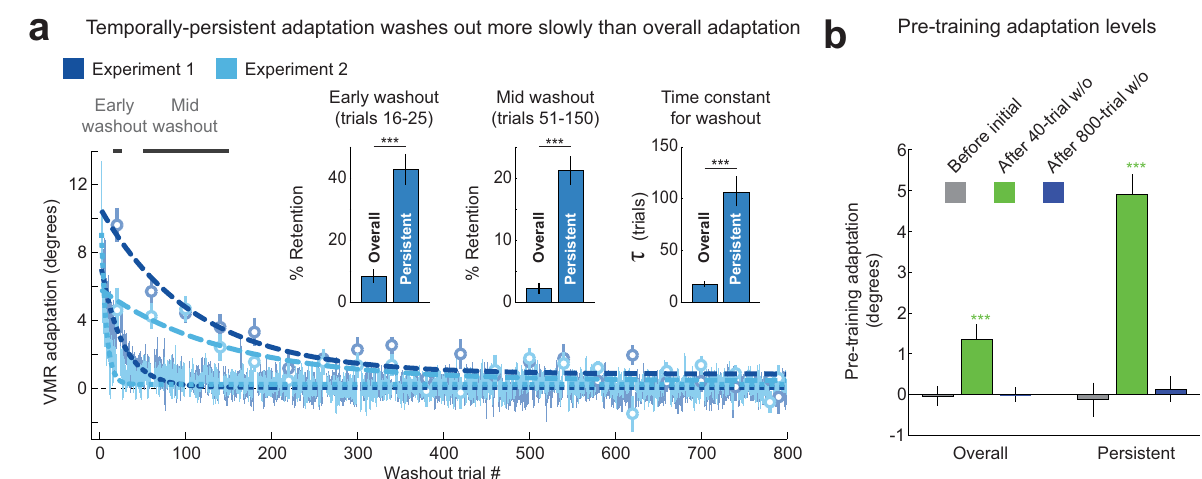
Fig 2. Temporally-persistent adaptation washes out more slowly than overall adaptation. (a) Washout curves for the overall adaptation (shading indicates mean ± SEM) and temporally-persistent adaptation (circles) for both Experiment 1 (blue) and Experiment 2 (light blue), illustrating the contrast between rapid washout for overall adaptation and slower washout for temporally-persistent adaptation. The thick dashed or dotted lines indicate exponential fits. Inset: Three different measures of washout for overall vs. persistent adaptation. Retention expressed as a percentage of asymptote adaptation after 16–25 trials (left) or 51–150 trials (center) indicates slower washout for temporally-persistent compared to overall adaptation. Time constants for the washout curves (right) also show slower washout for temporally-persistent adaptation. * p < 0.05, ** p < 0.01, *** p < 0.001. (b) Residual adaptation before initial training (gray, left bar in each cluster), at the end of the 40-trial washout period (green, middle bar) and at the end of the 800-trial washout period (blue, right bar). The data show that the 40-trial washout period leaves a significant amount of temporally-persistent adaptation and a smaller but also significant amount of overall adaptation. Consequently, retraining after only 40 washout trials starts from a nonzero baseline. * p < 0.05, ** p < 0.01, *** p < 0.001. Underlying data supporting this figure can be found in file